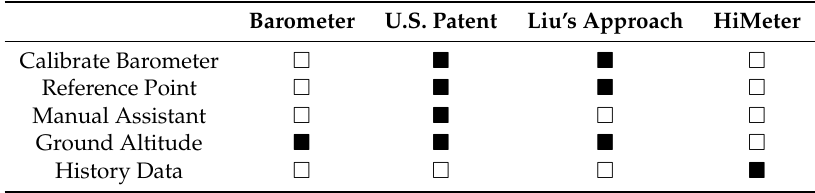
Table 3. The comparison of other performance